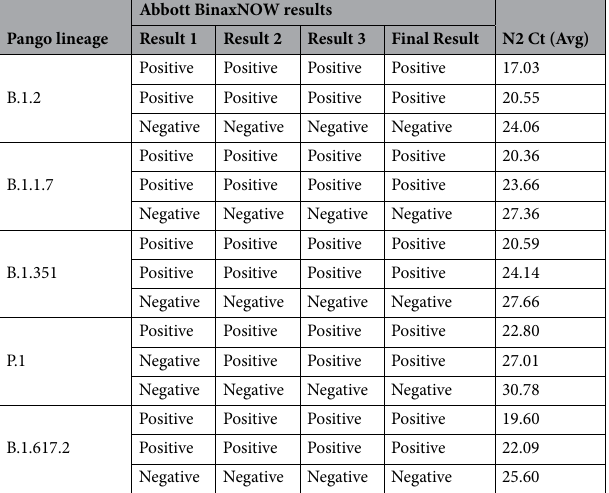
Table 3. VOC: results of Abbott BinaxNOW SARS-CoV-2 point-of-care antigen test against SARS-CoV-2 variants of concern (VOC), tested at the same